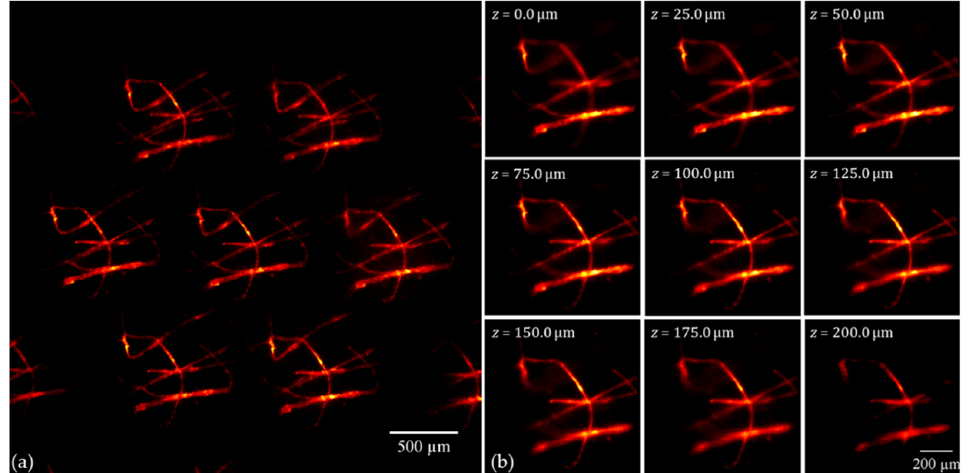
Figure 5. ( a ) EIs of the fluorescence knot of cotton fibers obtained with the handheld and cost- effective FLMic; the scale bar indicates the distance in the object space; ( b ) refocused images at different depth planes.